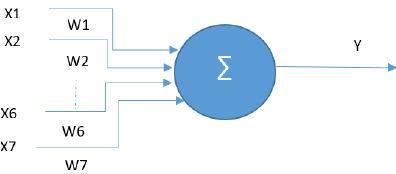
Figure 15. Single-layer perceptron model, with 7 inputs, 1 processing unit and 1 output.